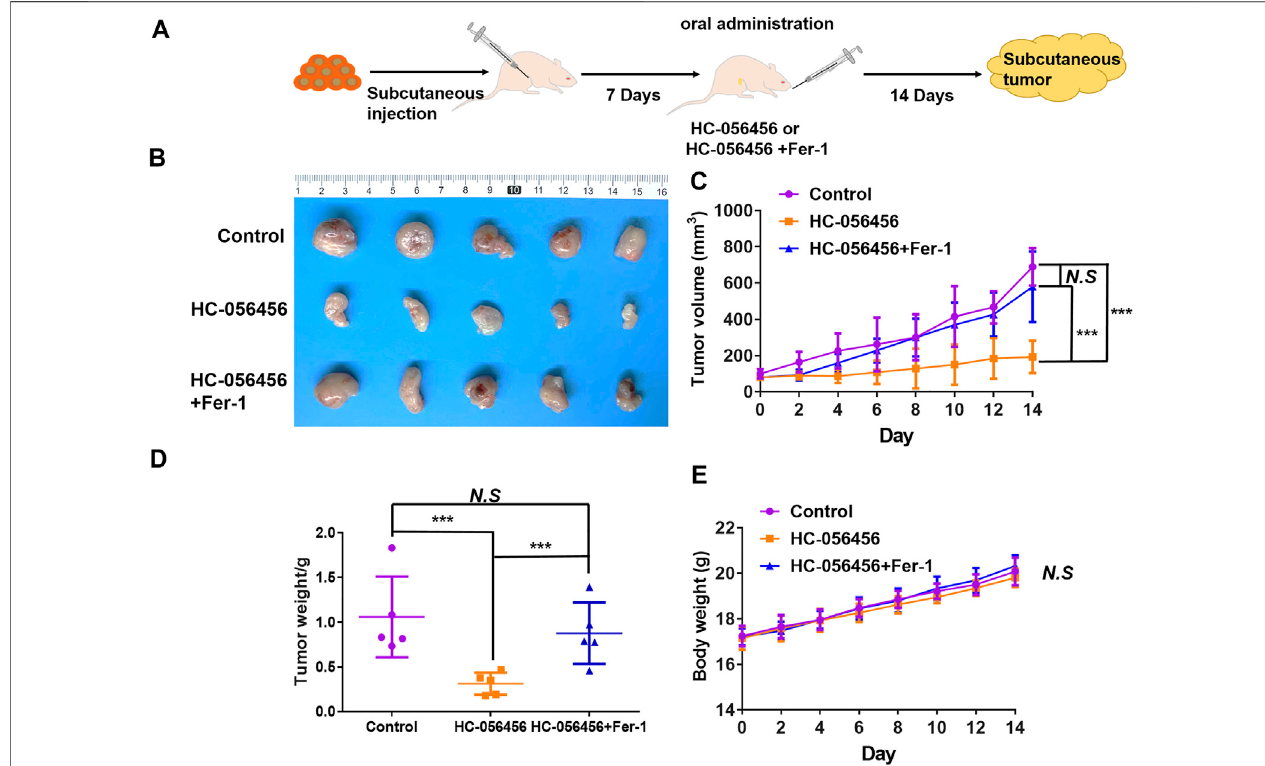
FIGURE 9 | HC-056456 inhibited MGC-803 cell growth in vivo by inducing ferroptosis in a partially dependent manner (A) MGC-803 cells were subcutaneously inoculatedinnudemiceatadensityof1×10 6 .7 dayslater(~100 mm 3 ),miceweretreatedwithvehicle,HC-056456(50 mg/kg/d),HC-056456(50 mg/kg/d),andFer-1 (50 mg/kg/d) for 14 days (B) Image of tumors was shown after HC-056456 intervention with or without Fer-1 (C) Tumor volumes were recorded every 2 days (D) Tumors were weighed and recorded (E) The weight of mice was monitored. * p < 0.05, ** p < 0.01, *** p < 0.001 versus control